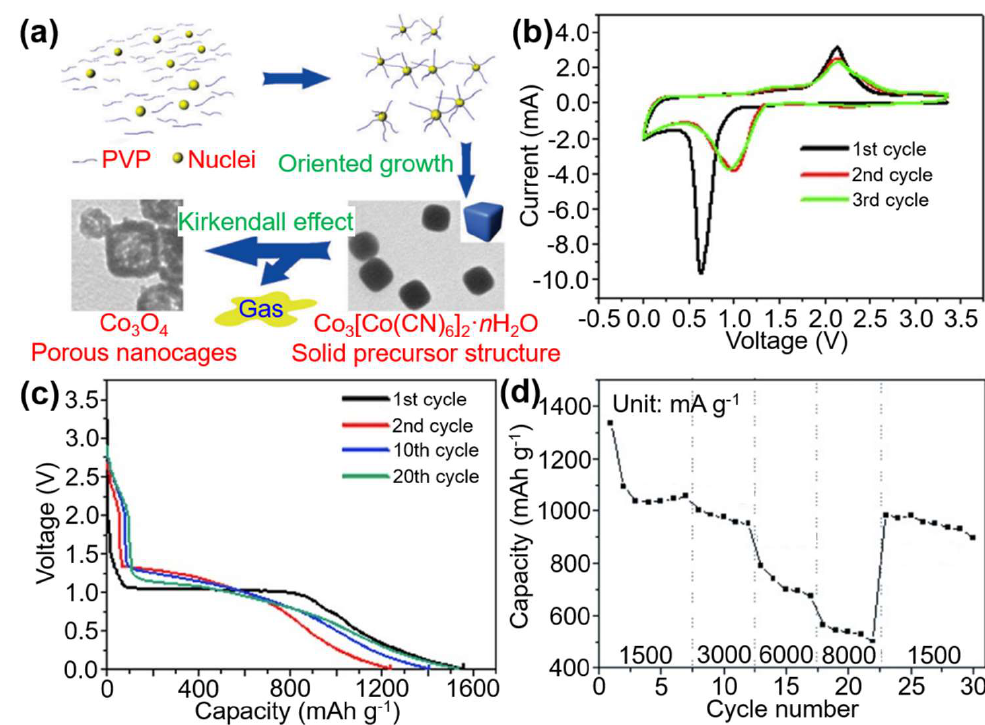
Figure 3. ( a ) Co 3 O 4 porous nanocages have been prepared from Co 3 [Co(CN) 6 ] 2 · nH 2 O truncated nano cubes based on the Kirkendall effect. ( b ) The first three CV curves of the Co 3 O 4 porous nanocages based anode material recorded at a scan rate of 0.5 mV s − 1 . ( c ) The 1st, 2nd, 10th, and 20th discharge curves of the Co 3 O 4 porous nanocage based anode materials at a current density of 300 mA g − 1 . ( d ) Rate capability of the as-prepared Co 3 O 4 porous nanocages. Ref. [15] Copyright A European Journal, Wiley Online Library.